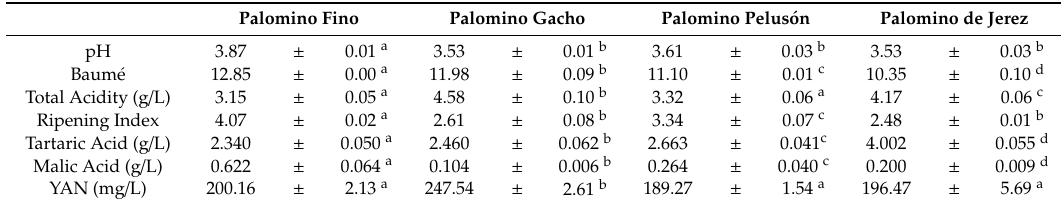
Table 3. Palomino Fino (control) and somatic variants (Palomino Gacho, Pelusón and de Jerez) grape must physicochemical characterization at harvest during the year 2016.